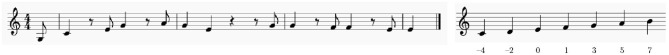
A list of suitable octave-invariant responses for the selected excerpt from the European dataset in C-major.